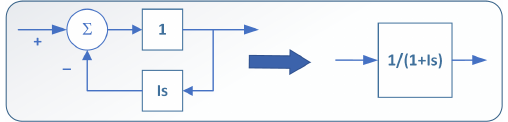
Figure A1. Block diagram to represent the operation 1/ ( 1 + Is )